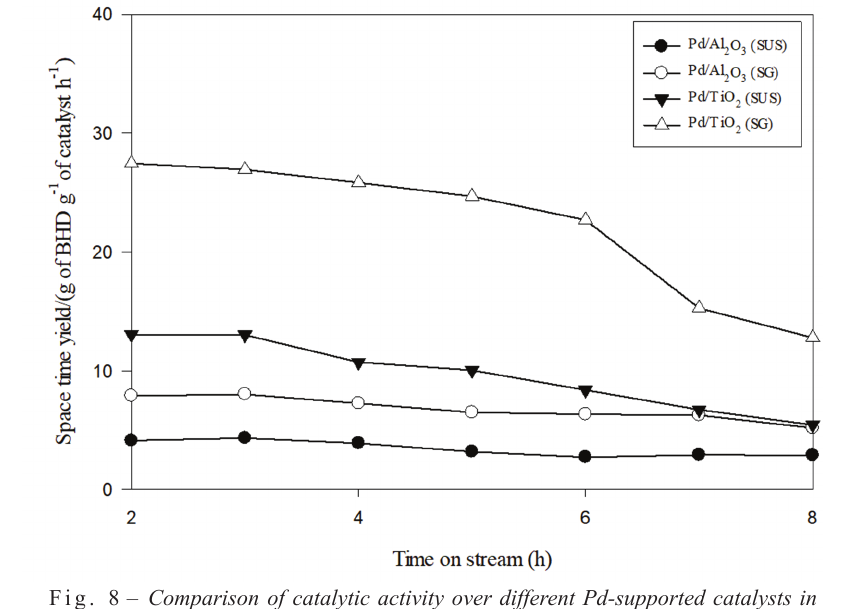
Fig. 8 – Comparison of catalytic activity over different Pd-supported catalysts in terms of space-time yield (STY), as a function of time on stream (reaction